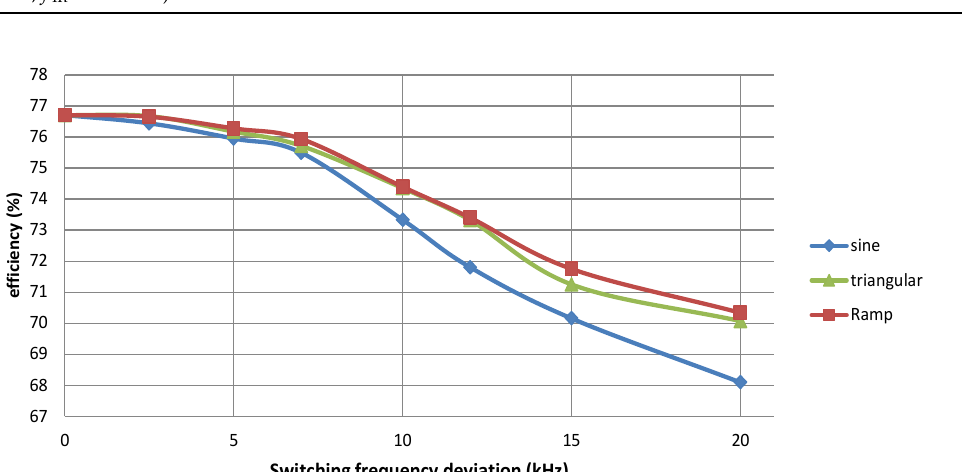
Figure 13. Measured efficiency versus Δ f peak when periodic SFM (with different modulation wave- forms and f m = 1 kHz) is used. Note: the efficiency of the WPT system without the spread spectrum is 76.7%.